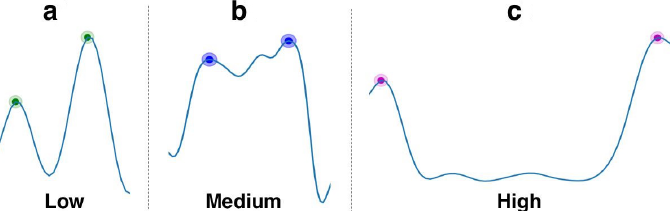
Figure 5. Three main frame similarity (FS) patterns encountered and their importance: ( a ) Single peaks, ( b ) High similarity plateau ≡ static camera, ( c ) Low similarity valley ≡ camera pan.